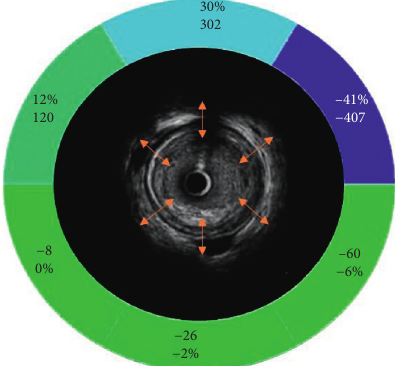
Figure 1: Representative image of the IVUS prestent implantation cross section. Representative image of the IVUS prestent im- plantation cross section that was measured using strain speckle tracking software. The left anterior descending vessel wall was divided into six 60-degree colored segments. The average of the six segments was calculated for total coronary vessel motion. The orange lines represent inward and outward motion (radial de- formation) and radial velocity that was measured for each of the six vessel wall